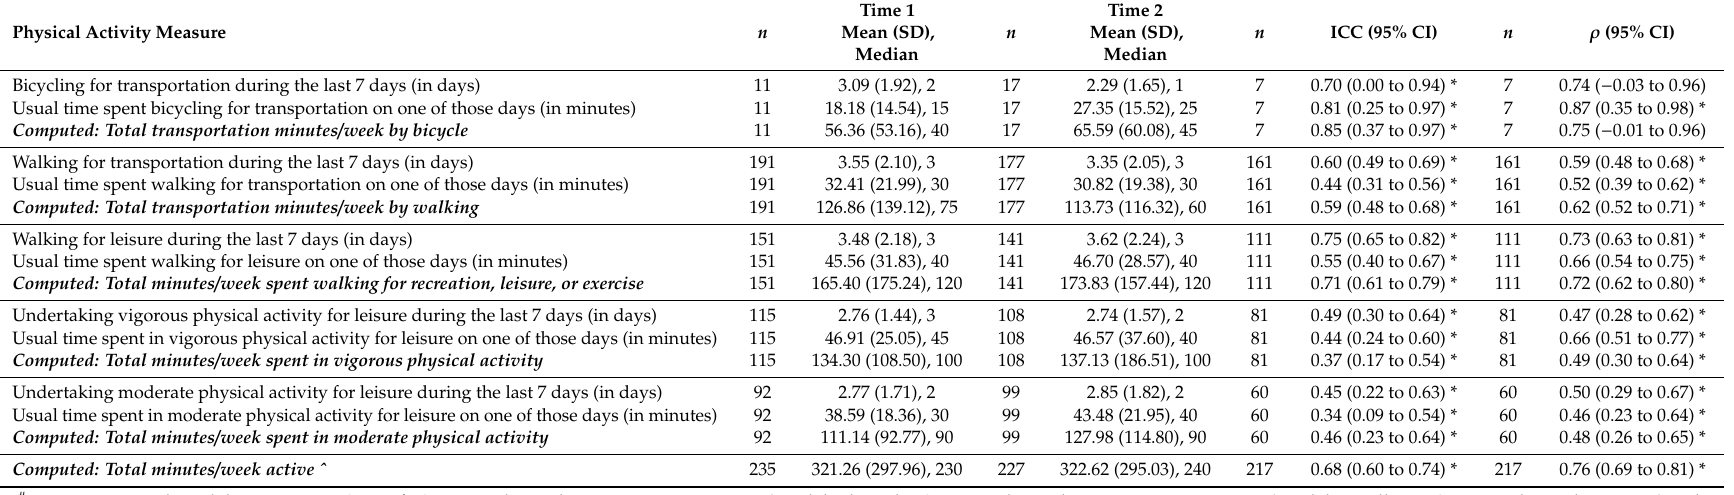
Table 4. Intraclass Correlations (ICC) # and Spearman’s rank correlation ( ρ ) for self-reported perceived neighbourhood physical activity between Time 1 and Time 2 for participants reporting